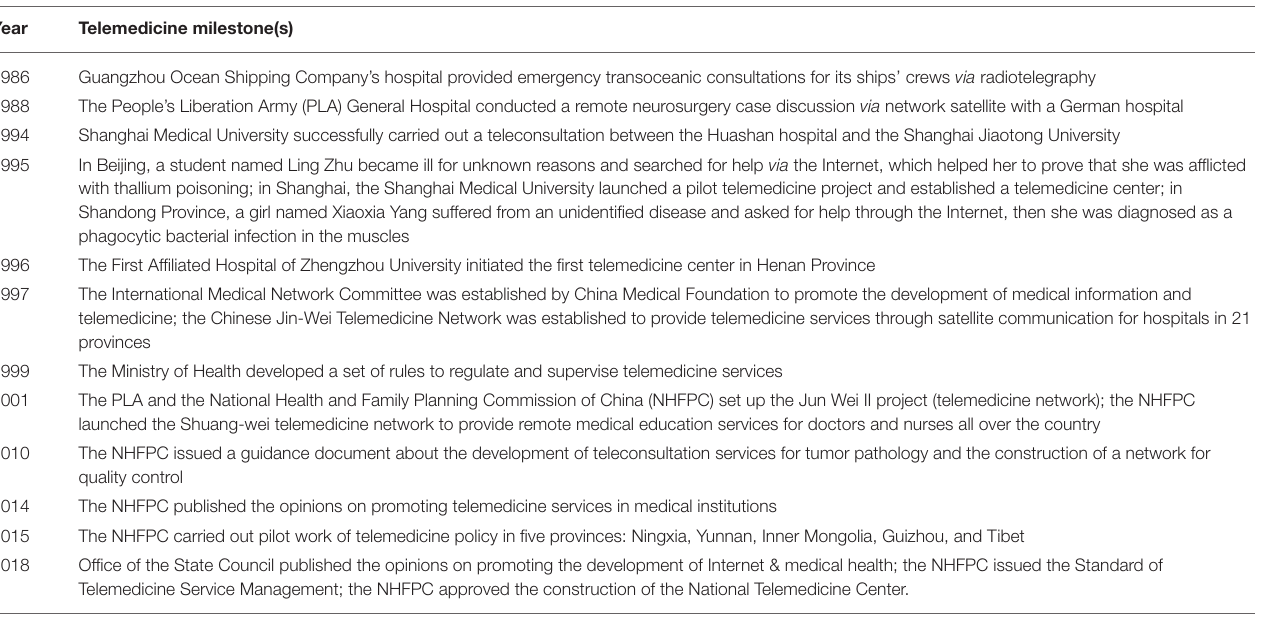
TABLE 1 | The development history of telemedicine in